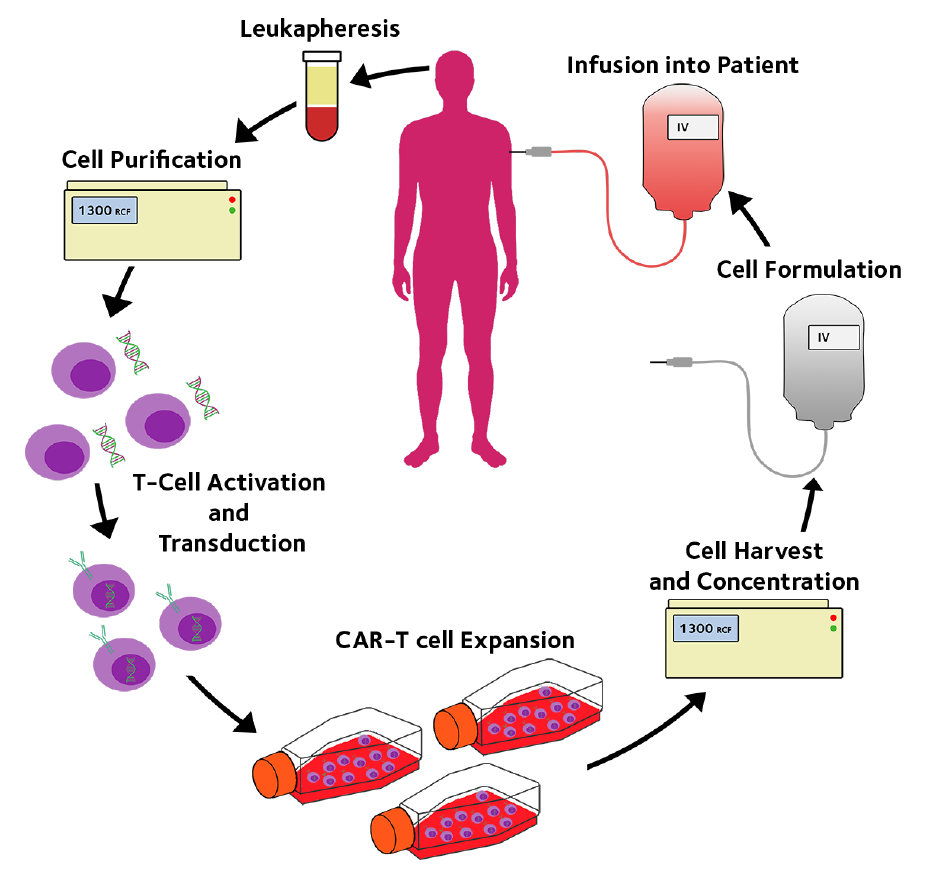
Figure 2. Simplified schematic of the processing steps in CAR-T manufacture for immunotherapy of cancers [8].